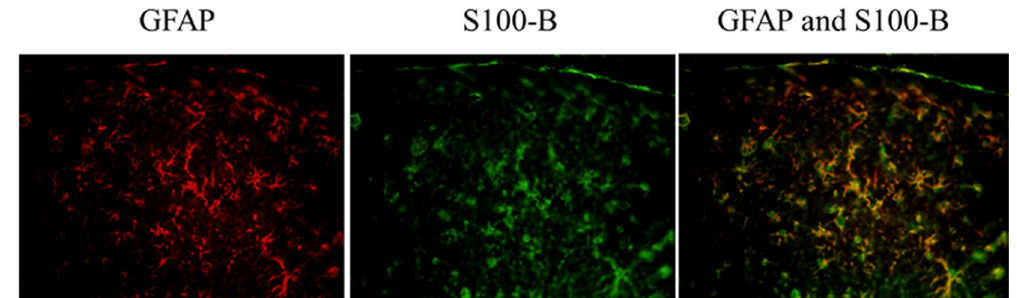
Figure 4. Effect of electrical stimulation at the ear and electro-acupuncture at ST36–ST37 observed on double immunofluorescence analysis in kainic acid-induced epileptic seizure rats. Double immunofluorescence analysis revealed the co-localization of GFAP (green) and S-100B (red) immunoreactive cells; the co- localization is marked with yellow (GFAP and